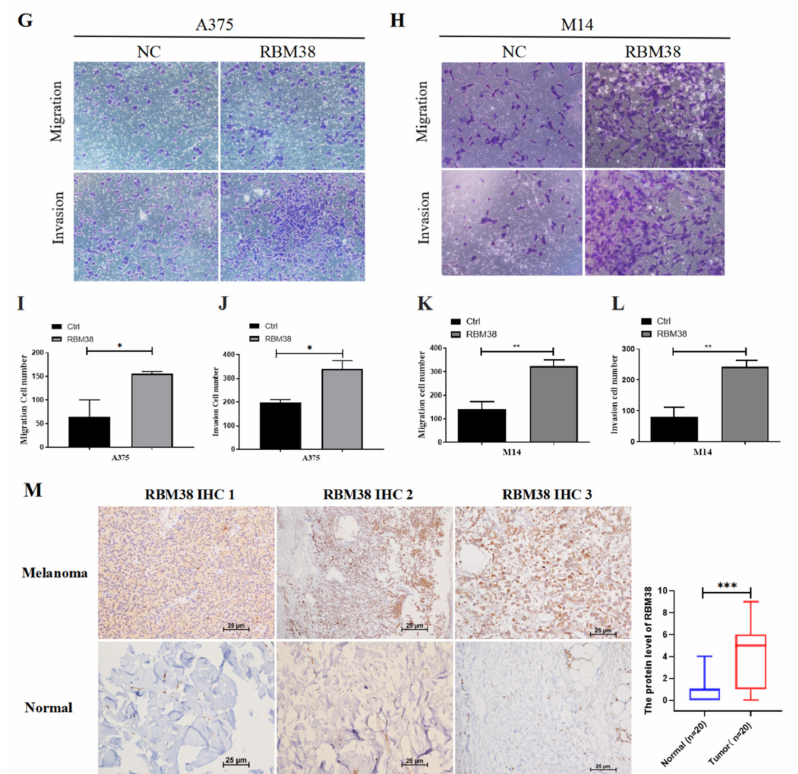
Figure 3. RBM38 promoted melanoma cell migration in vitro and in vivo and is highly expressed in melanoma tissues. ( A – F ) Effects of RBM38 knockdown on cell invasion and migration by cell invasion and migration assay in A375 and M14 cells (data are shown as the mean ± SD of three replicates). ( G – L ) Effects of RBM38 overexpression on cell invasion and migration by cell invasion and migration assay in A375 and M14 cells (data are shown as the mean ± SD of three replicates). ( M ) Representative images and statistical graphs of RBM38 staining in melanoma and normal tissues ( n = 20, *** p < 0.001) by IHC staining. Scale bars indicated 25 µ m. (For statistical comparison